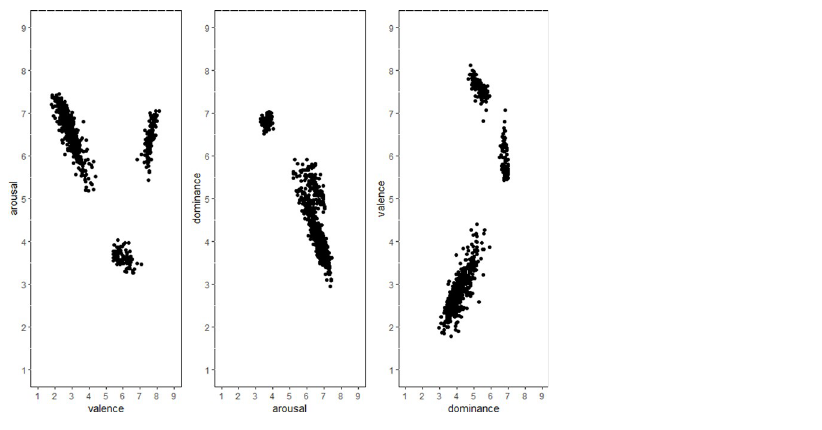
Fig 1. Scatterplot of